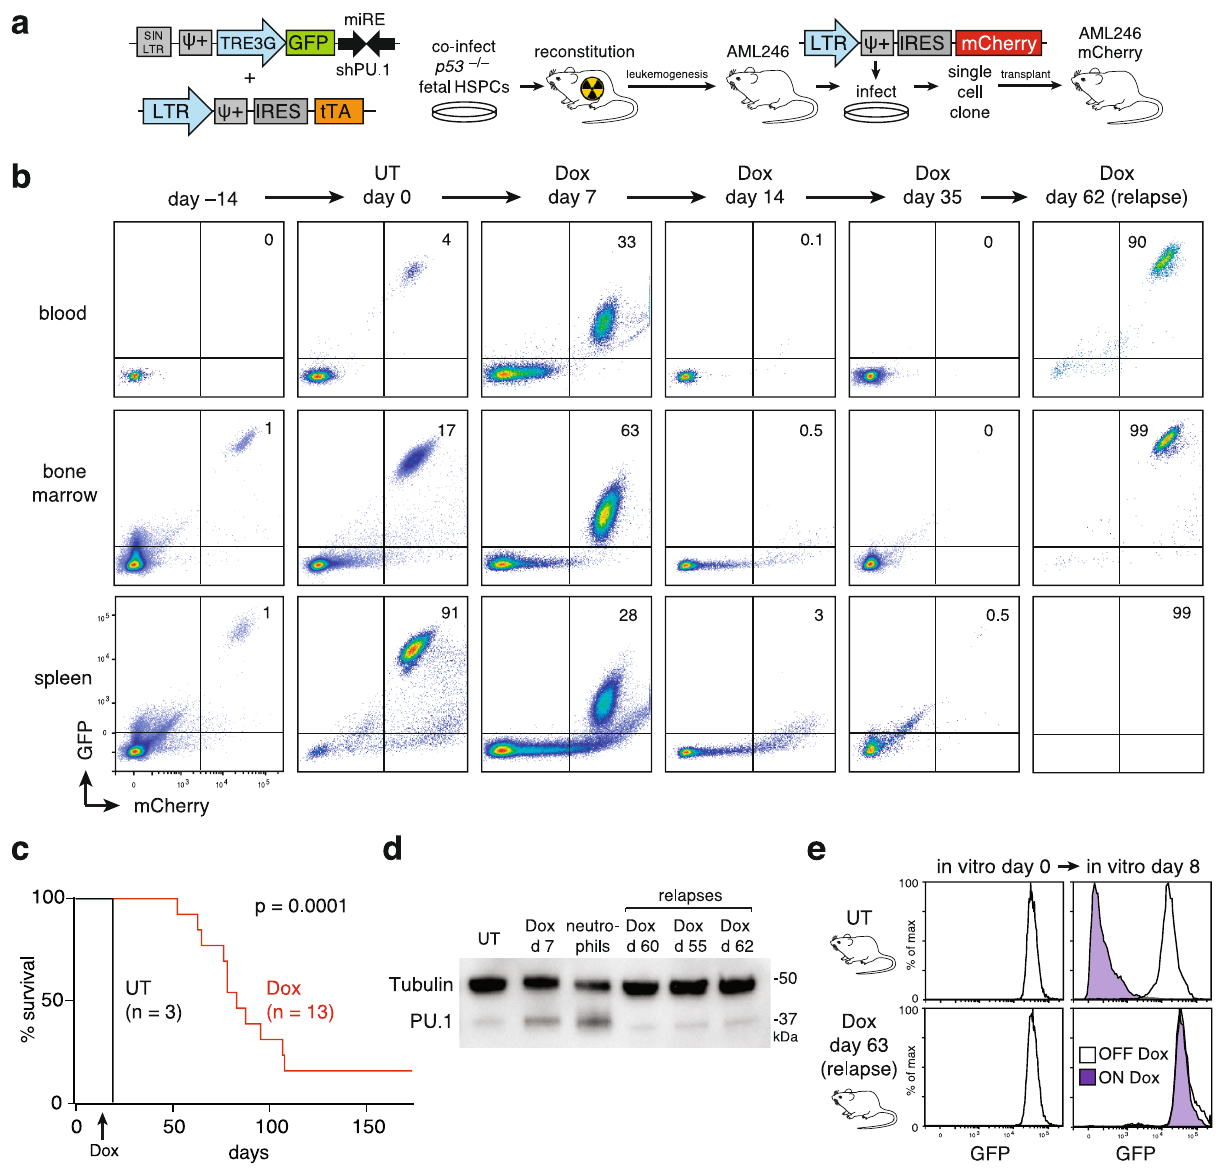
Fig. 1 An in vivo model of AML differentiation therapy regression, remission, and relapse. a Strategy for generating AML246-Cherry. b Flow cytometry analysis of disease burden (mCherry + cells) prior to and following Dox treatment in vivo. Data are from a representative mouse at each time point. Axis scales are shown on the lower left plot only. UT, untreated. All mice used in the study are listed in Supplementary Table 1. c Kaplan – Meier survival analysis of mice transplanted with AML246-Cherry cells at day 0 and either left untreated (UT; n = 3) or Dox treated ( n = 13) upon leukemia establishment as indicated. p = 0.0001, Mantel-Cox test. Source data are provided as a Source Data fi le. d PU.1 immunoblotting of AML246-Cherry cells from untreated mice, 8 day Dox treated mice, or mice relapsing on Dox, compared to control normal mouse Cd11b + Gr1 + neutrophils. Tubulin loading control. The blot was performed once. Source data are provided as a Source Data fi le. e GFP fl ow cytometry of GFP + mCherry + AML246-Cherry cells isolated from the bone marrow of mice that had relapsed during Dox treatment. Cells were cultured with or without Dox for 8 days then analyzed. AML246-Cherry cells isolated from an untreated mouse (GFP + mCherry + but Dox-sensitive) were used as